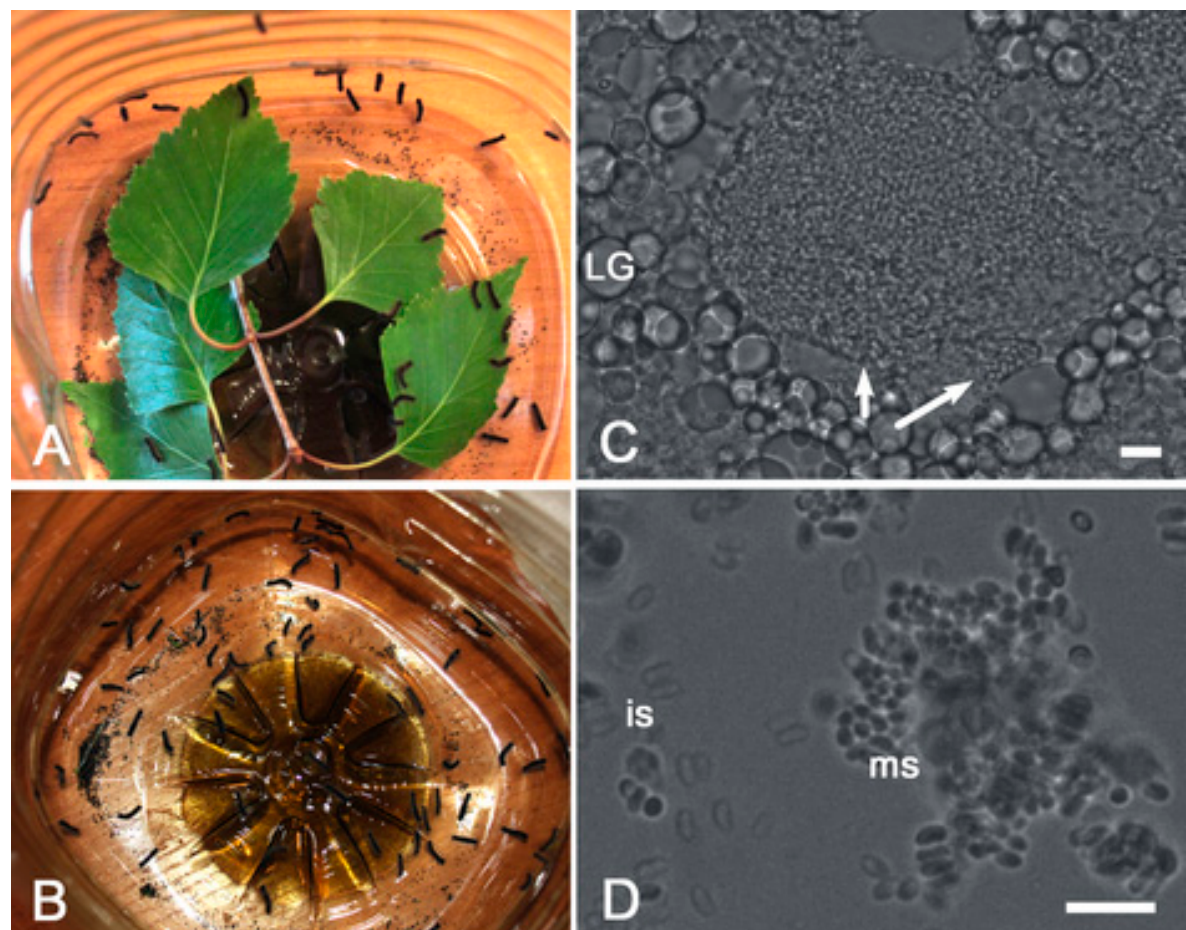
Figure 2. Infection of Lymantria dispar larvae with microsporidia. ( A , B ) A sample group of larvae before ( A ) and after ( B ) the contaminated birch leaves were consumed. ( C , D ) Bright field microscopy showing parasite spore-loaded infected cells (arrows) surrounded with lipid granules (LG) of uninfected cells, as well as immature (is) and mature spores (ms) on a smear. Scale bar = 10 micrometers.